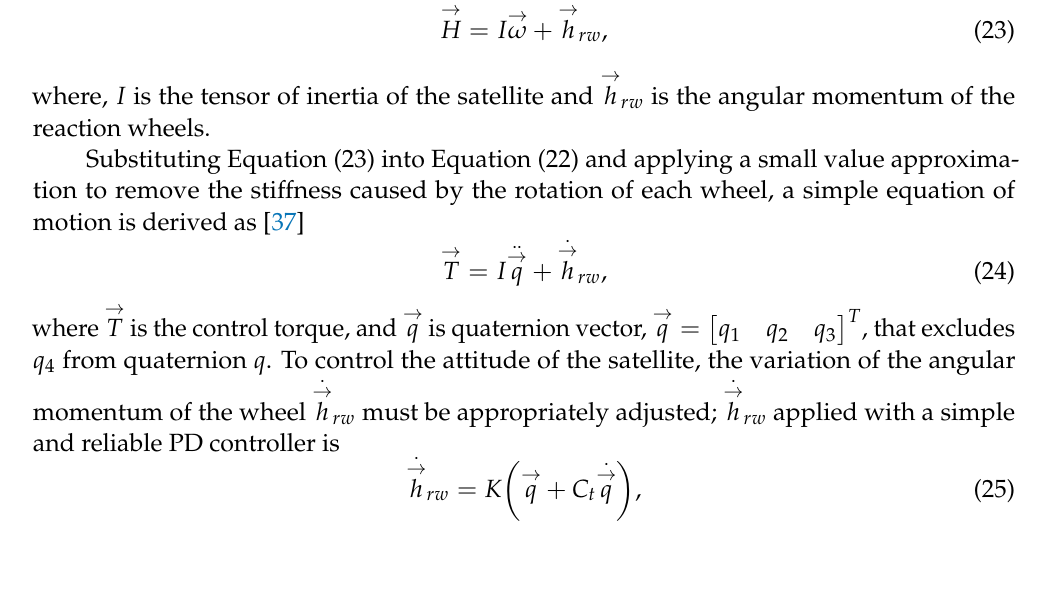
Figure 14. Flowchart of the autonomous attitude-control algorithm for multistatic SAR imaging with the 𝑅𝐴𝐷𝑁 (cid:3042)(cid:3043) concept applied. the RADN op concept